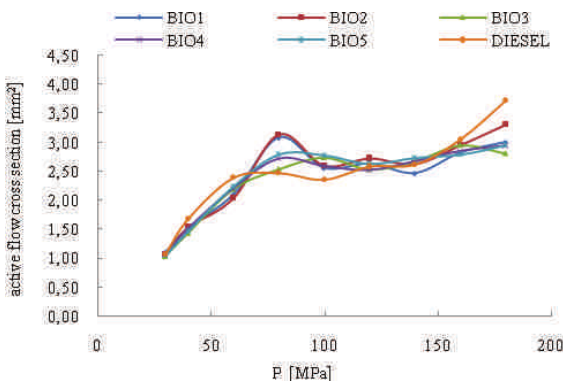
Fig. 5. Comparison of the active flow cross sections of tested fuels at 60°C So far, the fuel flow through the injector has been ana- lyzed at the same temperatures. Many authors point to dif- ferences in viscosity and density of diesel and biofuels [6, 9, 10, 24] indicating that heating of the fuel by 20 or 30°C relative to the diesel temperature results in a level of viscos- ity and density. A similar analysis was done at work Rybak et al. [19]. It has been shown that the active flow cross section for diesel at 40°C and for FAME at 60°C reach similar values over the range of utility pressures (30 to 180 MPa). Therefore, in Figure 6 comparison of the active flow cross sections of tested biofuels at 60°C and Diesel at 40°C was presented.